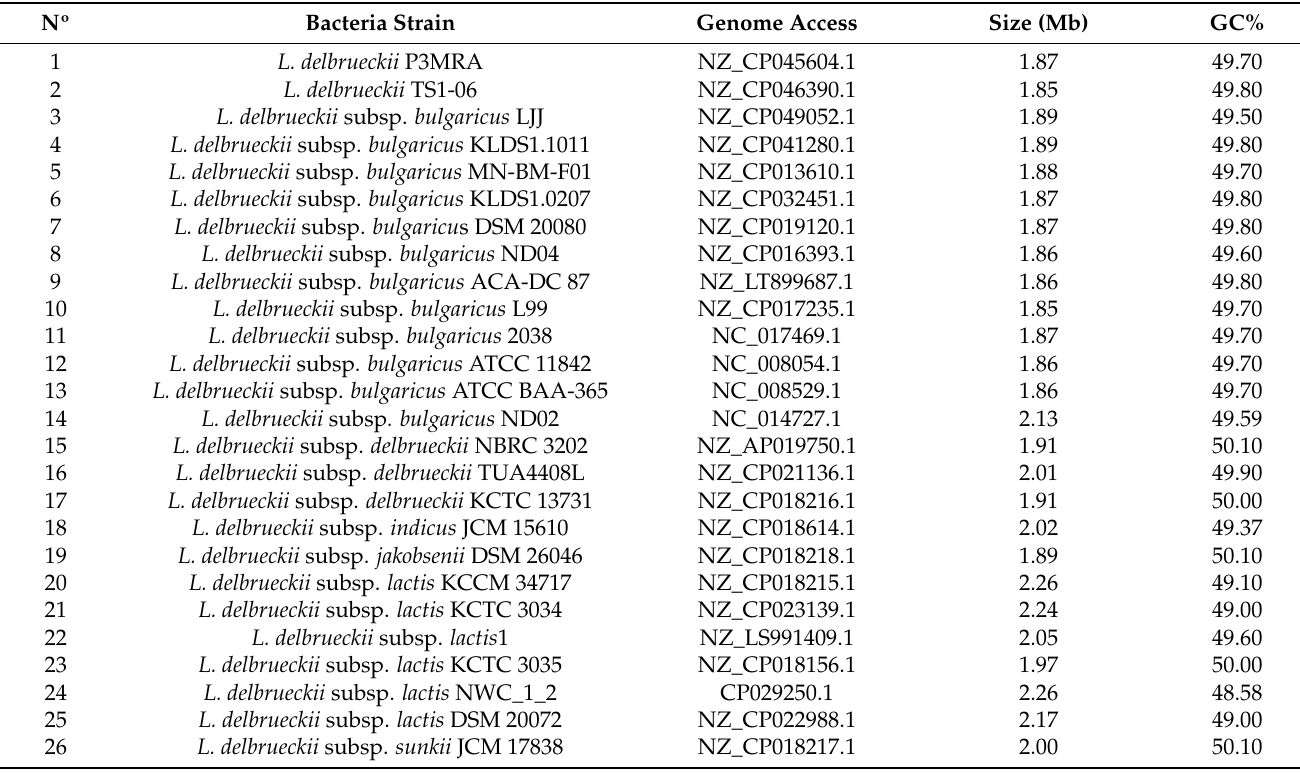
Table 1. Complete genomes of Lactobacillus delbrueckii strains obtained from NCBI used in comparative analysis. Nº Bacteria Strain Genome